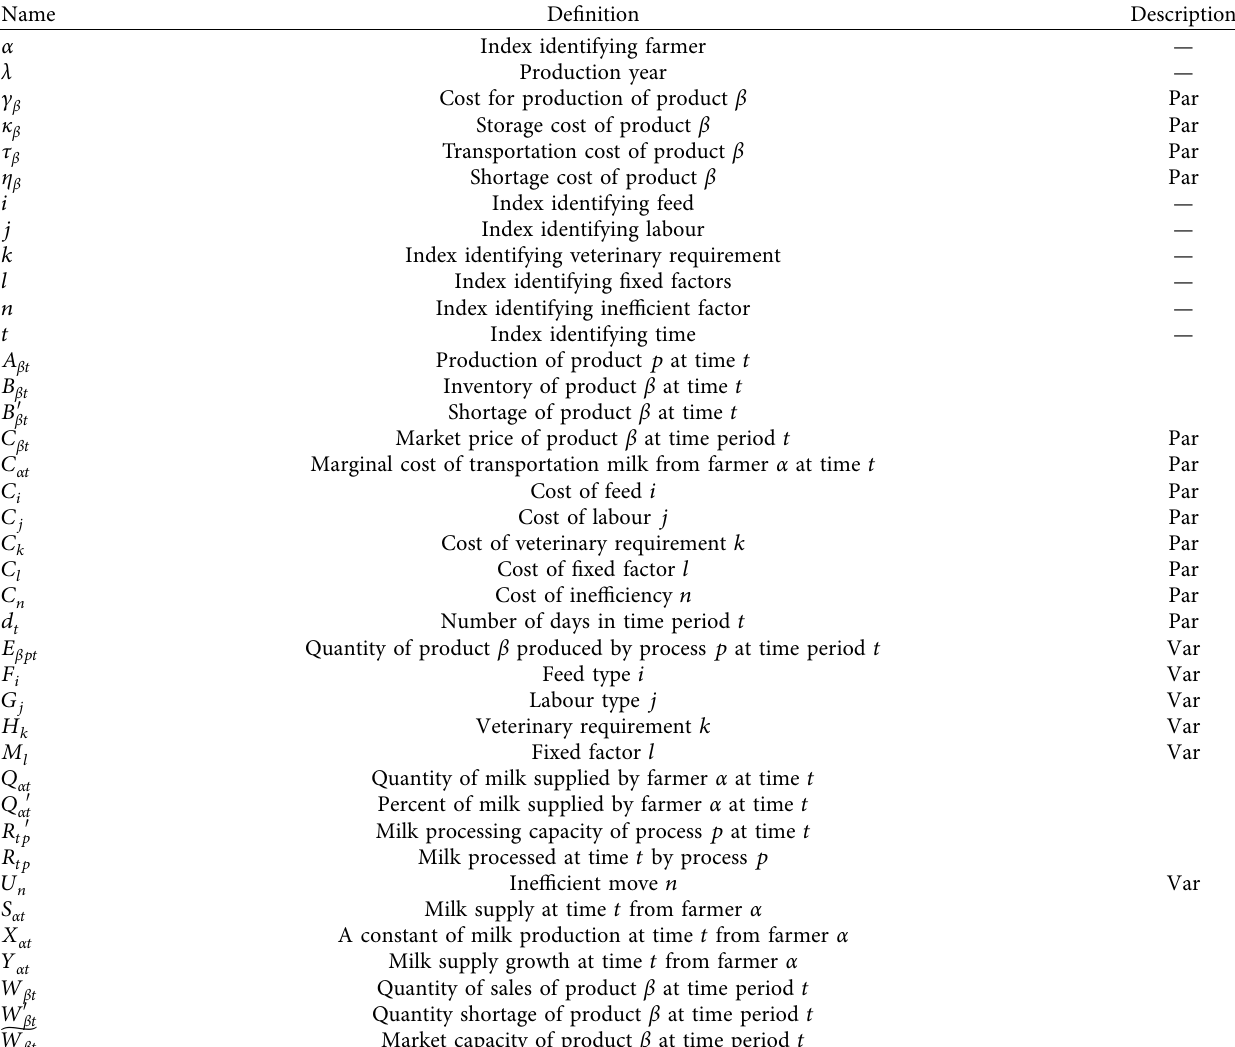
Table 1: Definition of parameters and